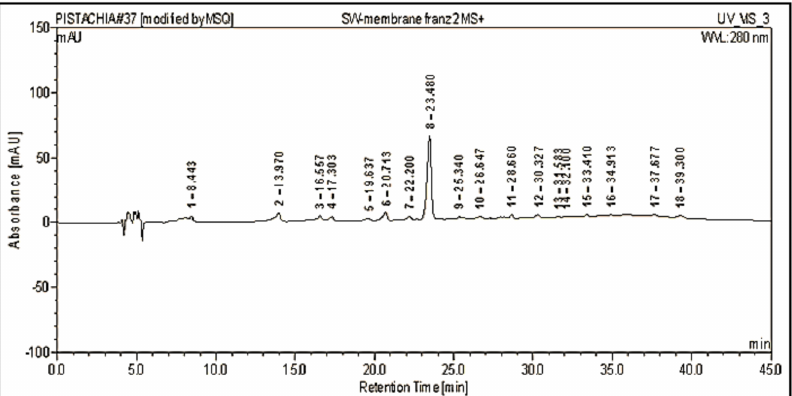
Figure 5. Chromatographic profile of the receptor medium of Franz cell after diffusion of 5% EAE- hydro-cream formulation through the start-M membrane, acquired by HPLC-MS at 280 nm. The peak assignments are listed in Table 3.